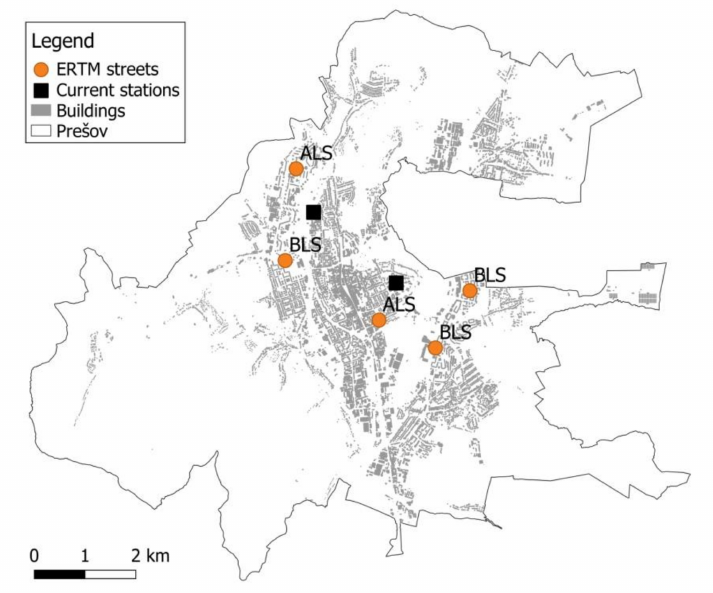
Figure 8. Ambulance locations using the ERTM model with the street demand